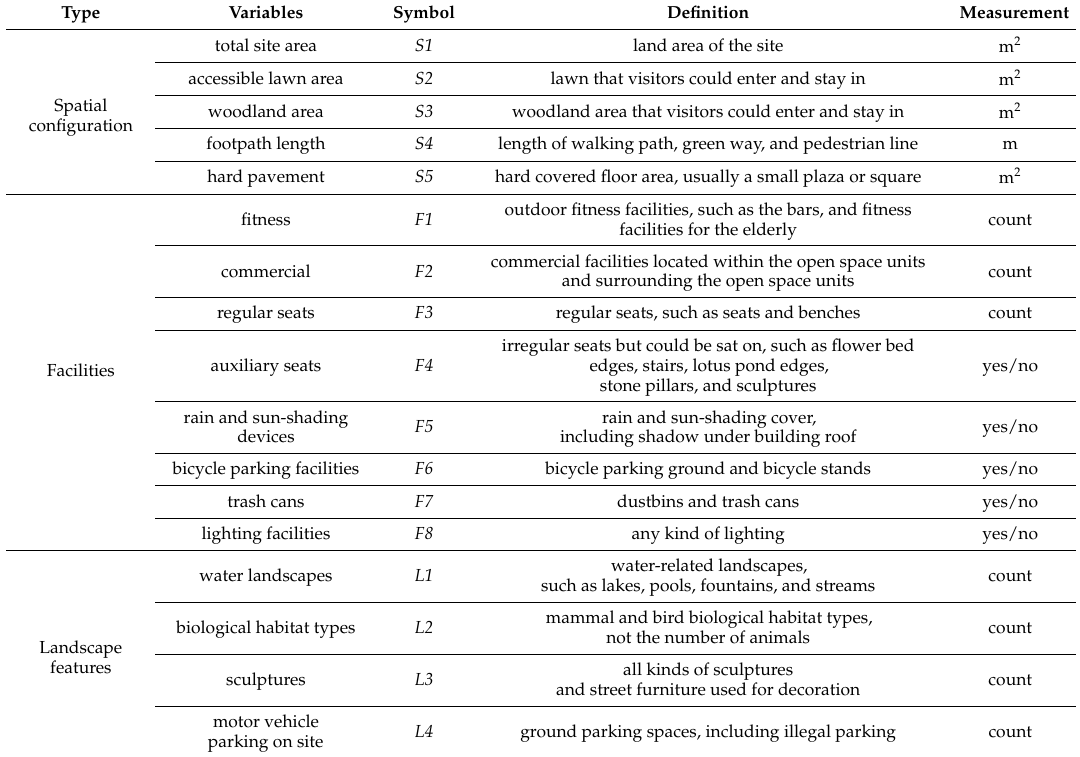
Table 1. Information of variables in the environmental